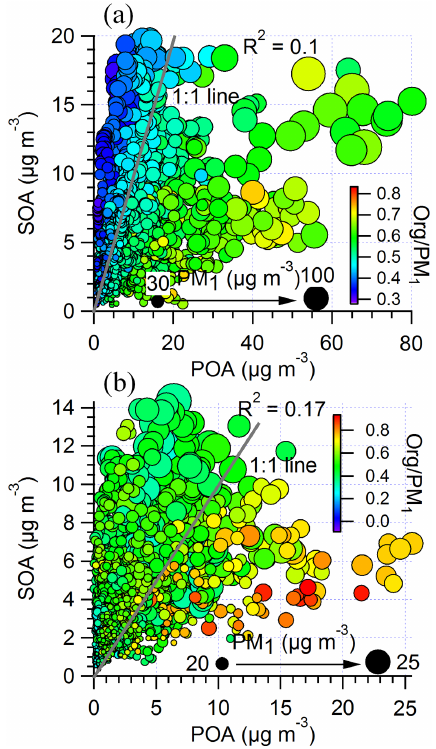
Figure 10. The scatterplot of SOA and POA colored by the ratio of organic (Org) / PM 1 and sized by the mass concentration of PM 1 for (a) winter 2013/2014 and (b) summer 2012.